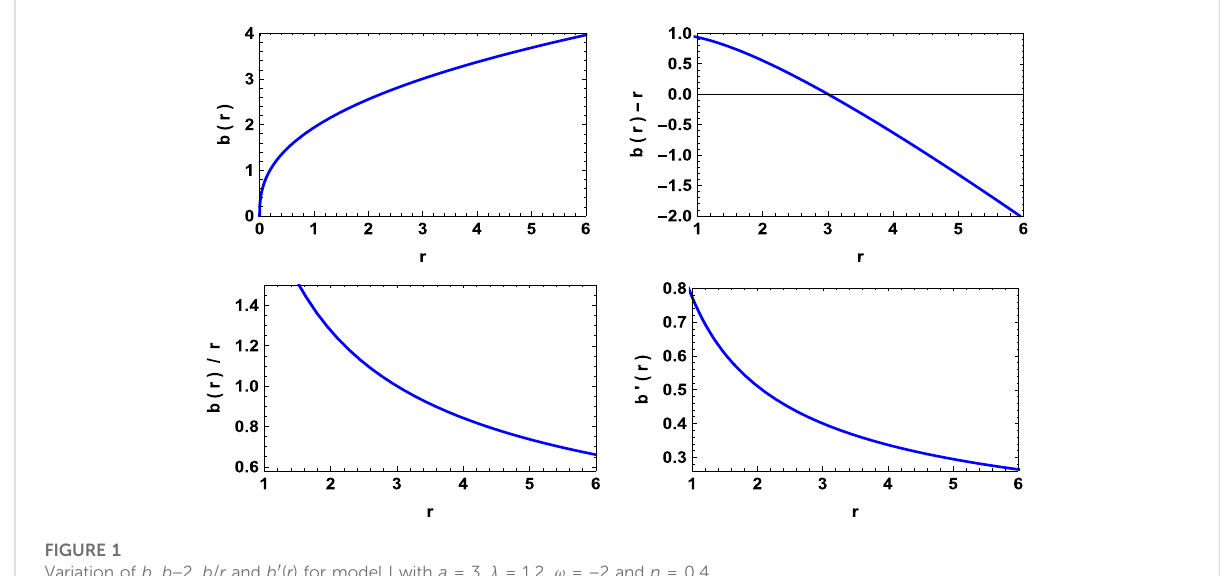
FIGURE 1 Variation of b , b − 2, b / r and b ′ ( r ) for model I with a = 3, λ = 1.2, ω = − 2 and n =